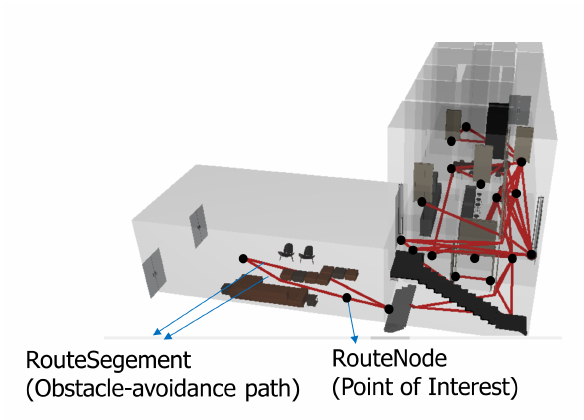
Figure 4. Example of RouteNode and RouteSegment which